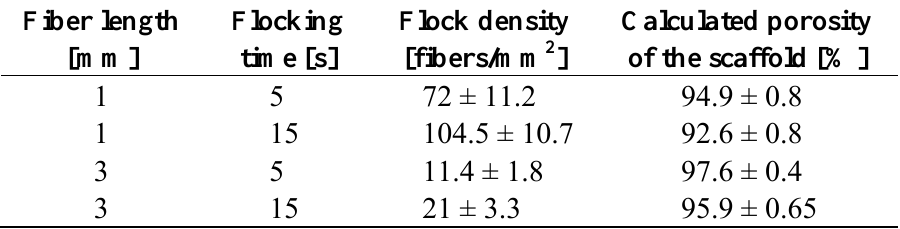
Table 1. Flocking density and porosity of the four different scaffold